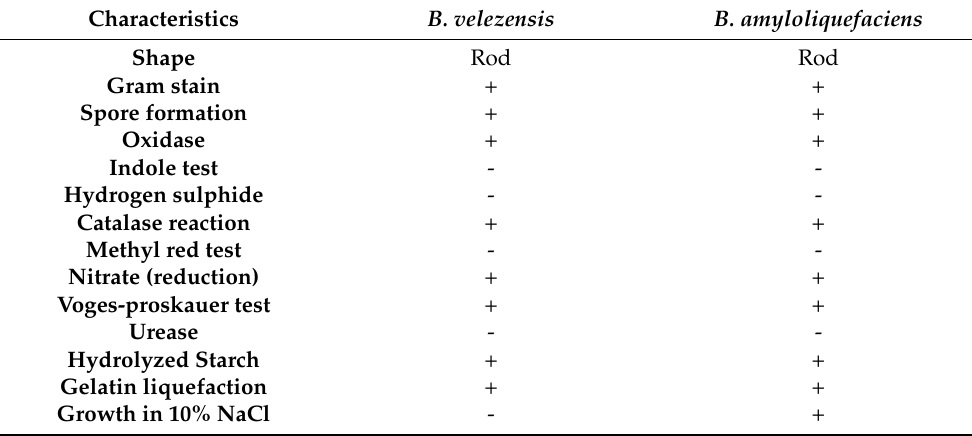
Figure 3. Inhibitory effects of selected endophytic bacterial isolates (E 3 , E 5 , R 1 , R 2 , T 4 , T 5, and C 1 ) against Alternaria sp. and Helminthosporium sp. using the well diffusion method ( A ) and the disc diffusion method ( B ). Table 3. Morphological and biochemical tests of as Bacillus amyloliquefaciens and Bacillus velezensis Table 2. Antagonistic activity of selected endophytic bacterial isolates against Helminthosporium sp. and Alternaria sp. in vitro .